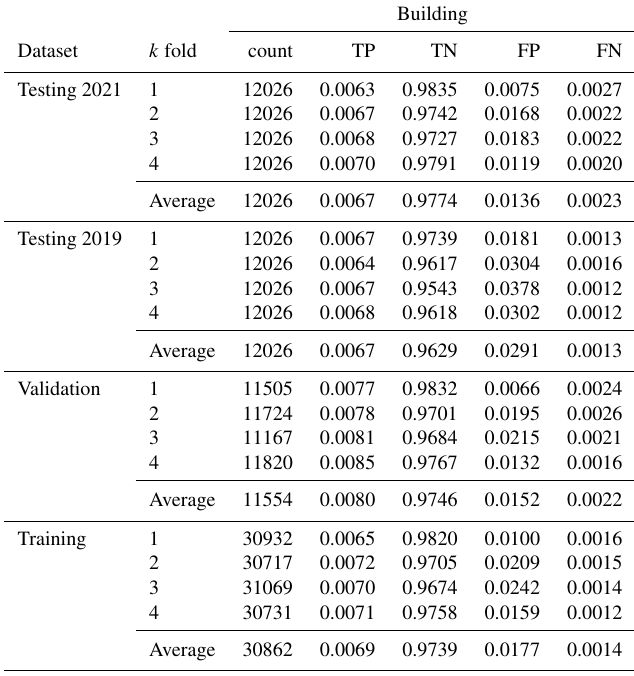
Table A5. Full confusion matrix for the green roof identification method, calculated based on counts of buildings. TP, TN, FP, and FN are as a proportion of total building footprint area.